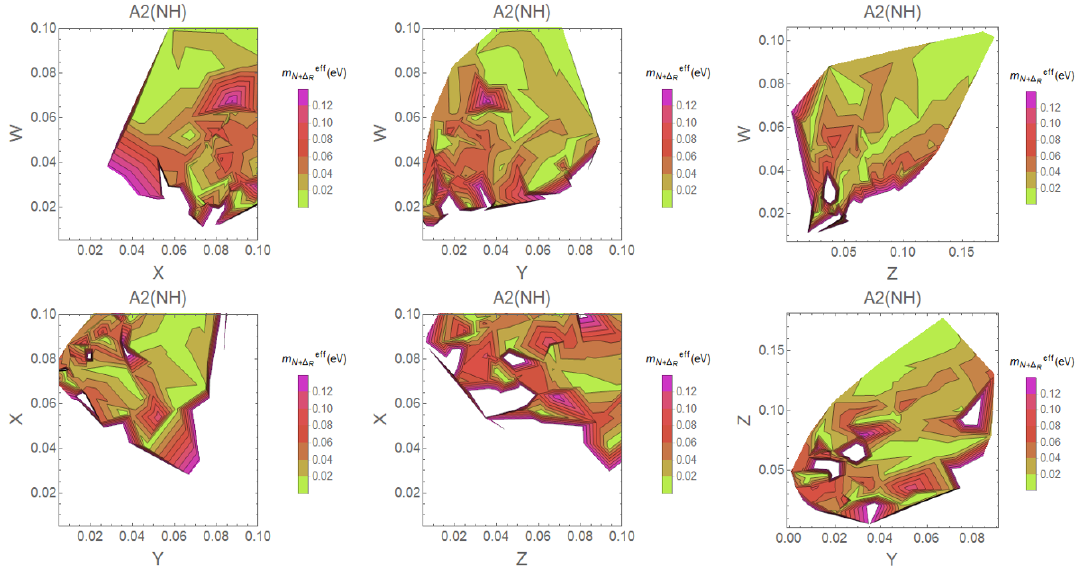
Figure 10 . The various combinations of type II SS model parameters (in eV) with the new physics contribution to e(cid:11)ective mass as the contour, where 0.061 eV is the KamLAND-Zen upper limit in A2 class of two texture zero neutrino mass matrix for normal hierarchy.